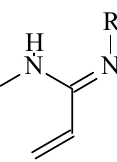
Figure 5. Structure of N,N’-substituted acryloamidines, where R and R’ are alkyl substituents. N,N’-substituted acryloamidines do not affect the glass transition temperature of PAN: it is 97 ± 1 ◦ C at a comonomer mole fraction of 1–19%. At the same time, they lower the melting point of the polymer, which, for example, for a copolymer with an acryloamidine mole fraction of 18–19%, R = R’ = 2-propyl, and M n = 20–24 kg · mol − 1 and Ð = 1.8–2.0 is ~140 ◦ C. In an air atmosphere, TOS starts at ~140 ◦ C and proceeds very intensively, while in an inert atmosphere, the intensity of the heat flux during cyclization is 5–6 times lower, and its onset is observed at temperatures 10–15 ◦ C higher. An additional decrease in the melting point to ~130 ◦ C is achieved by the addition of 10% DMSO or DMF. As a result, fiber is formed by extrusion of the melt in an inert atmosphere, and TOS is realized by heat treatment in air at 250 ◦ C. The stabilized fiber was subjected to carbonization at 1400 ◦ C in an inert atmosphere and carbon fiber was obtained with the following characteristics: tensile strength is equal to 0.94 GPa and elastic modulus to 85 GPa. It should be noted that both the precursor fiber obtained using a comonomer with R = R’ = 2-propyl and carbon fiber had a smooth surface, and no porous structure was observed. Replacing one isopropyl group with a tert -butyl group (R = tert -butyl, R’ = 2-propyl) leads to a slight defect structure of both the precursor and the final carbon fiber and to a decrease in tensile strength to 0.88 GPa, but an increase in the elastic modulus to 110 GPa. Obviously, these characteristics are lower than for typical solution-spun carbon fibers [152]; however, firstly, the diameter of the fibers was significantly higher (>12 µ m), and TOS and carbonization parameters can be optimized. In addition, the precursor fiber requires drawing to increase its orientation and crystallinity.